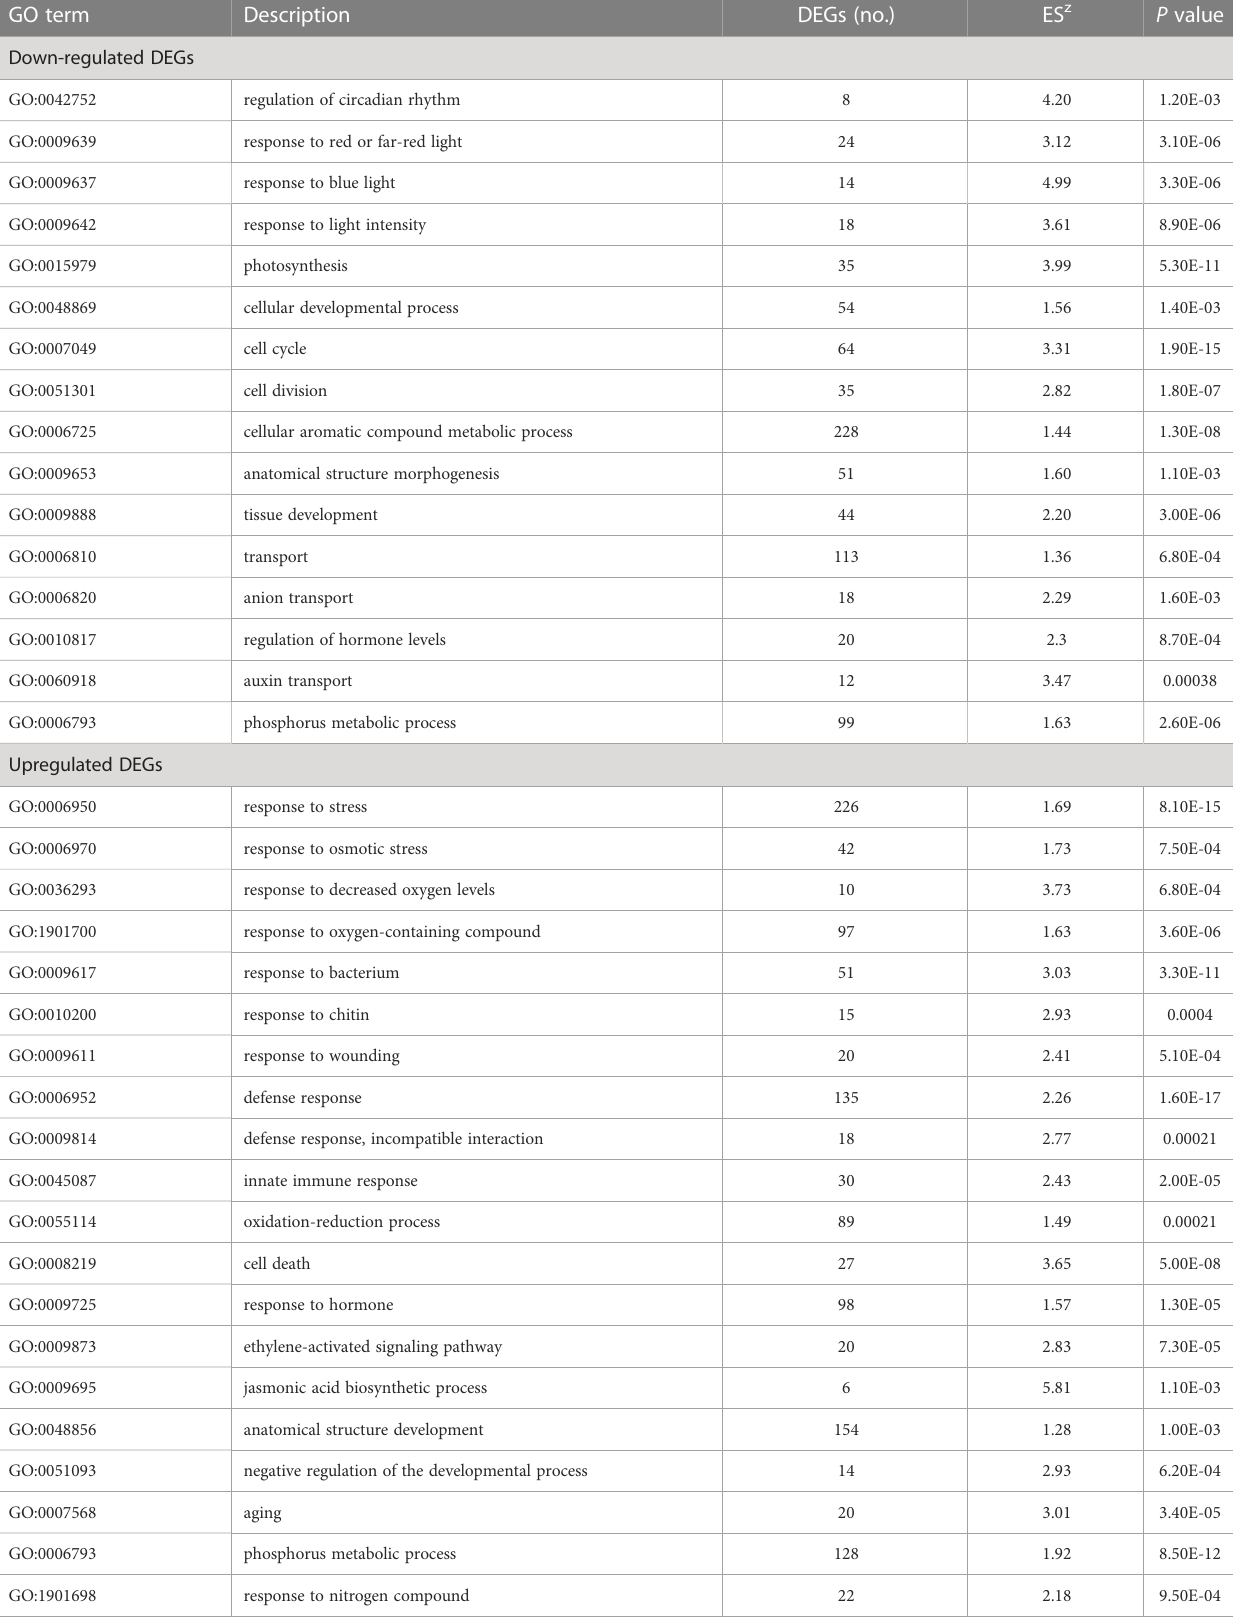
TABLE 2 A subset of GO categorization relating to the biological process of downregulated and upregulated differentially expressed genes (DEGs) in buds of severely symptomatic Huanglongbing (HLB)-affected ‘ Hamlin ’ sweet orange trees compared to mildly symptomatic trees in February. GO term Description DEGs (no.) ES z P